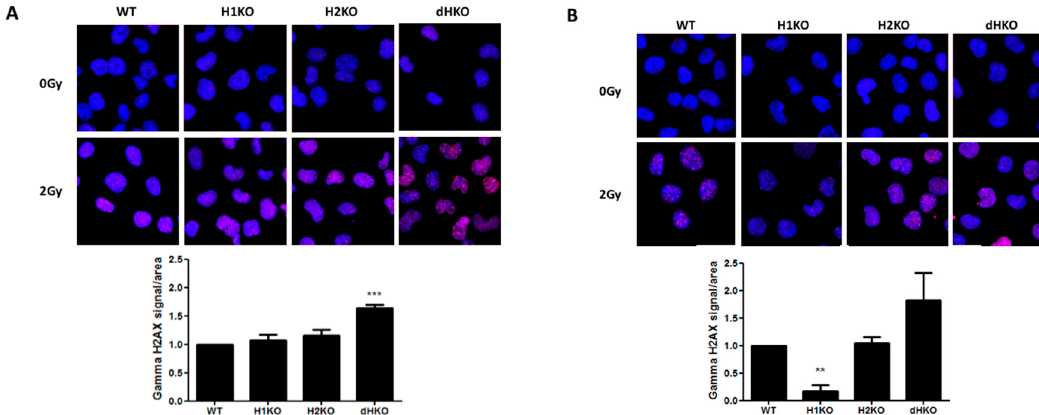
Figure 3. Representative merged fluorescent images of γ -H2AX foci (red) and nuclei (blue) upon irradiation under ( A ) normoxia and ( B ) hypoxia in H1299 cells. Quantification of γ -H2AX staining in cells. Average ± SD of three independent biological repeats is shown. Asterisks indicate statistical significance (** p < 0.01; *** p < 0.001).